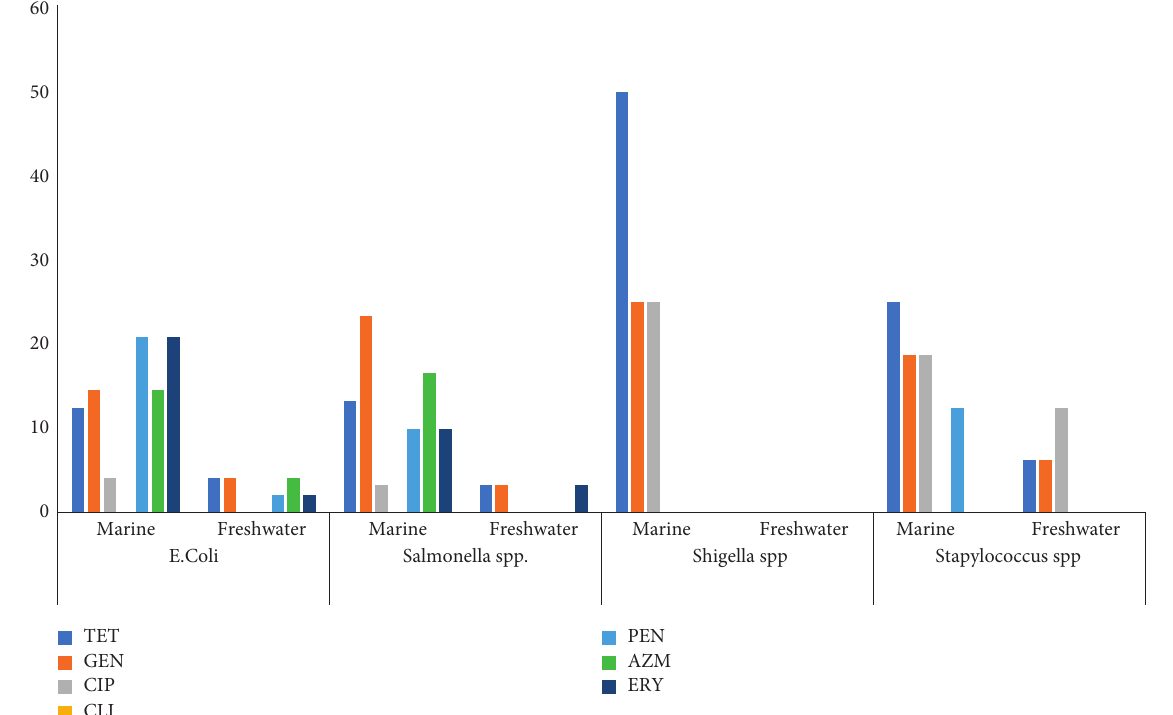
Figure 2: Prevalence of bacterial spp. resistance to antibiotics isolated from open-air markets and supermarkets. ∗ TET � tetracycline; GEN � gentamicin; CIP � ciprofloxacin; CLI � clindamycin; PEN � penicillin; AZM � azithromycin; ERY �